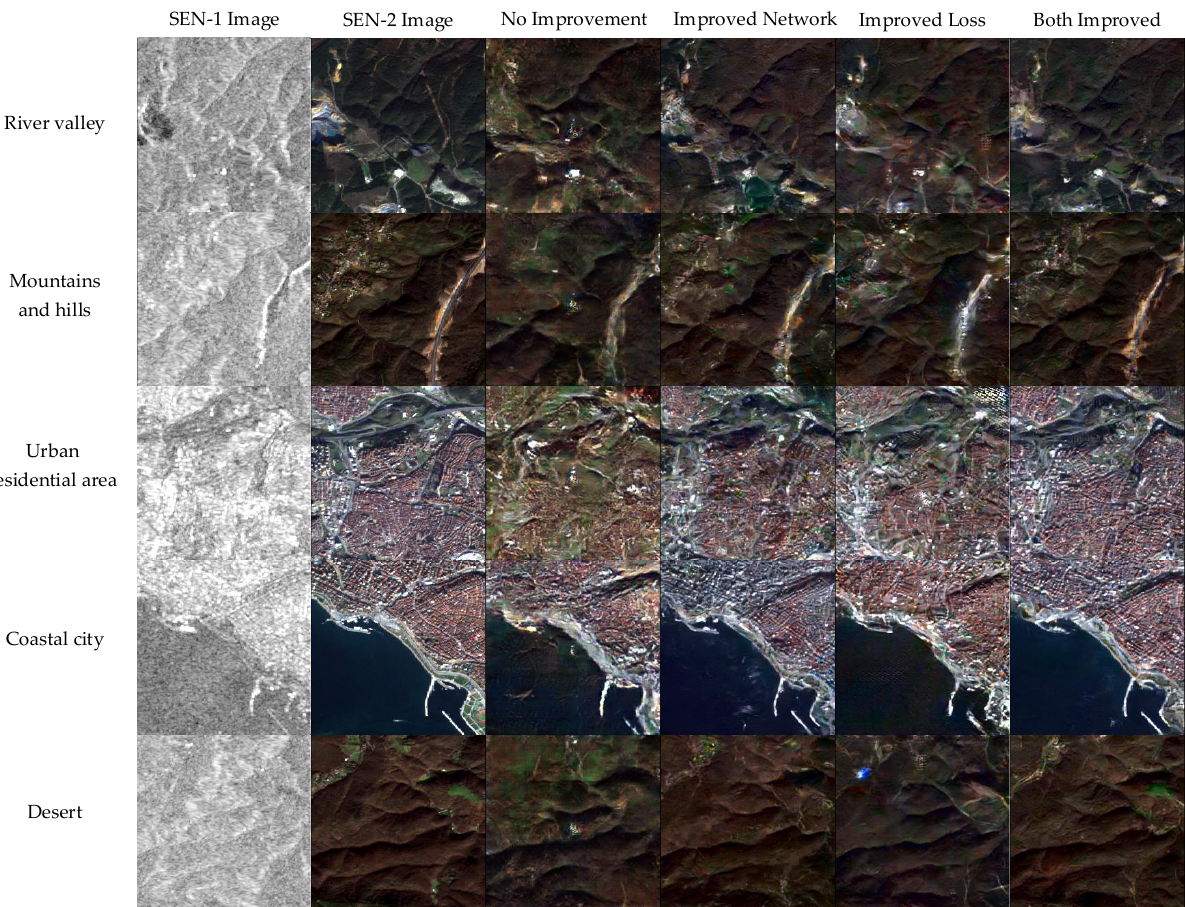
Figure 8. Results produced under different conditions. From top to bottom, the images are remote sensing images of five kinds of landscape: river valley, mountains and hills, urban residential area, seashore, and desert. From left to right: SEN-1 images, SEN-2 images, images generated by Group 1, images generated by Group 2, images generated by Group 3, images generated by Group 4.